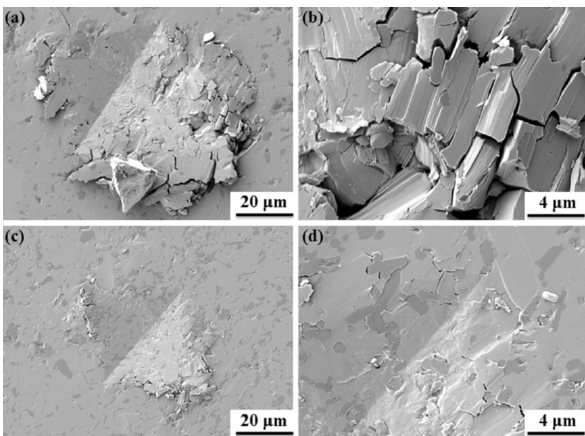
Fig. 8 Bending strength of the SiC w /Ti 3 SiC 2 containing different amount of SiC w .